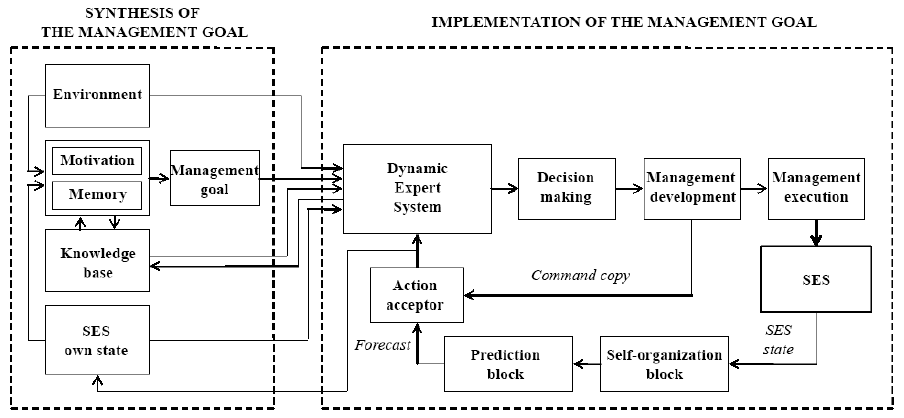
Fig. 1. Schematic diagram of the intellectual system for managing the innovative development of a complex socio-economic